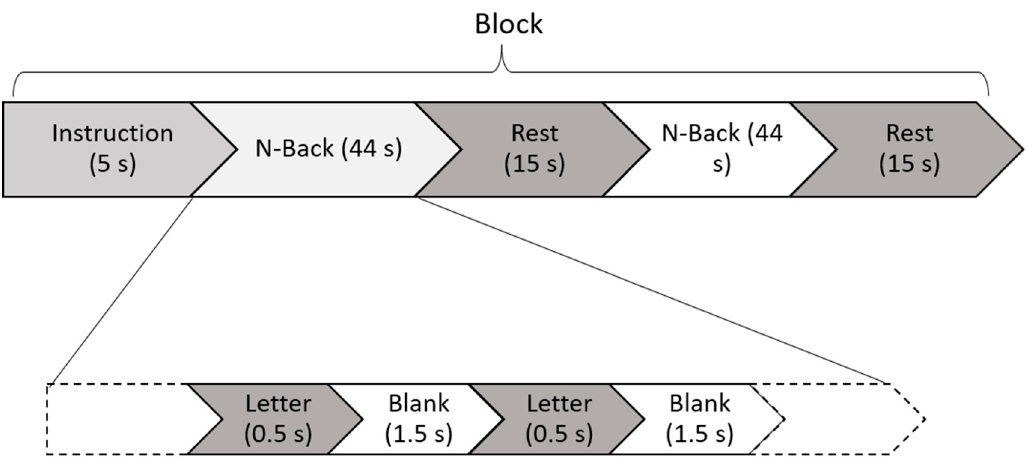
Figure 1. The N-back task flow for this study. The task consists of three periods: a 5 s instruction, a 44 s N-back trial, and a 15 s resting period. During the N-back trials, di ff erent letters were shown on the monitor in front of the participant, who was asked to click on the target letters as quickly and accurately as